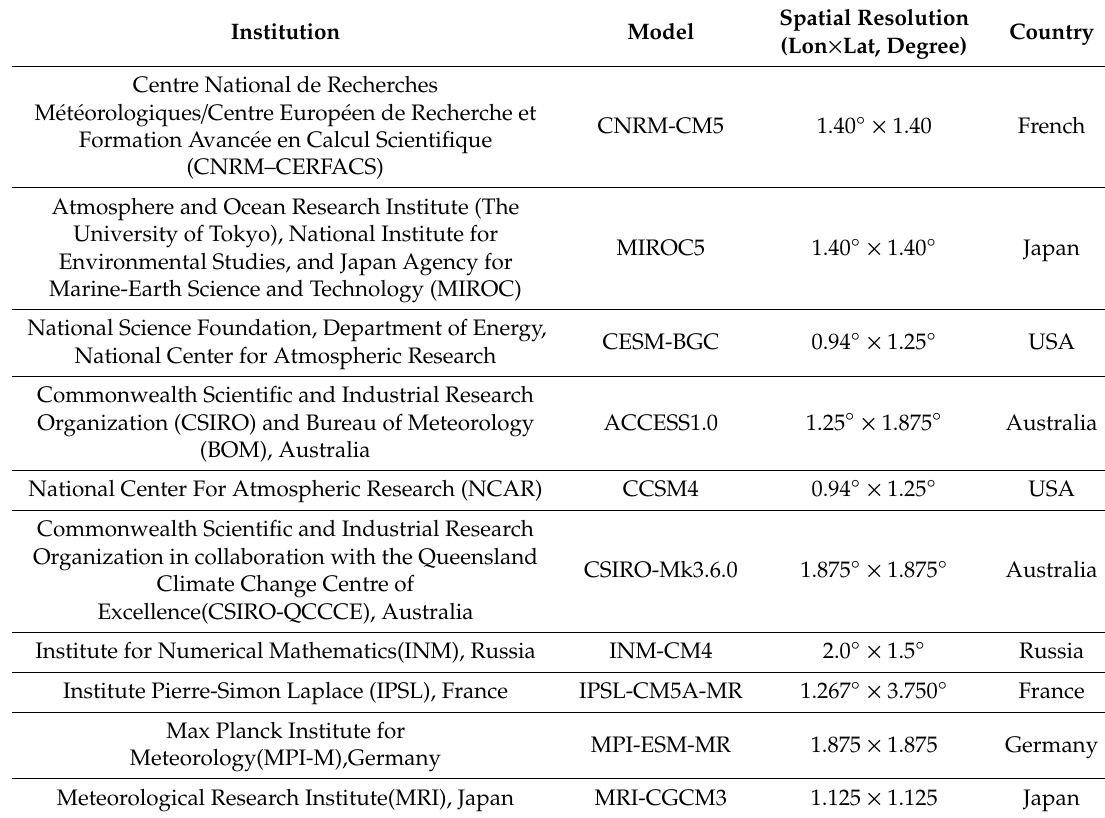
Table 1. Information on the 10 climate models used in the present